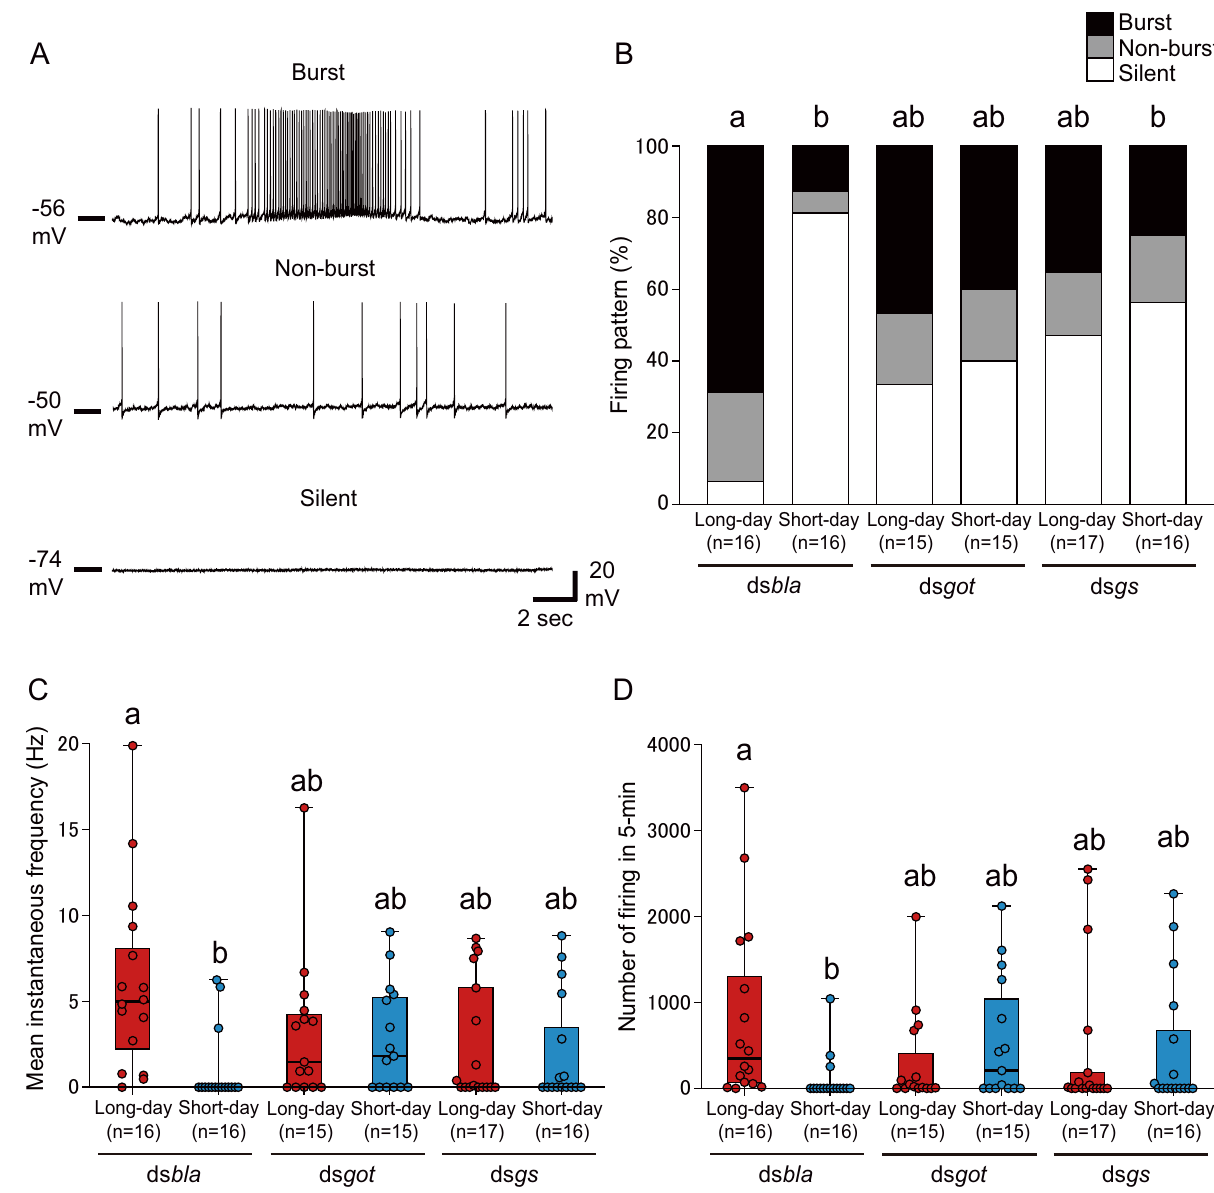
Fig 3. RNAi of got and gs disrupts photoperiodic responses in large PI neurons. (A) Representative traces showing burst (upper), non-burst (middle), and silent (lower) patterns in PI neurons. (B) Columns showing proportions of the 3 firing patterns in ds bla- , ds got -, and ds gs -injected females under long-day and short-day conditions. (C, D) Box and scatter plots showing the (C) mean instantaneous frequency and (D) number of firing events in 5 min in each group. (B–D) Columns and box plots with different letters indicate statistically significant differences (B: Tukey-type multiple comparisons for proportions [“silent” rate comparison]; C, D: Steel–Dwass test, P < 0.05). (C, D) Lines at the top, middle, and bottom of the box plots indicate the upper quartile, median, and lower quartile, respectively. Upper and lower whiskers of the box plots indicate the maximum and minimum values, respectively. The underlying data can be found in the S1 Data datasheet of numerical values for each fig.xlsx. PI, pars intercerebralis; RNAi, RNA